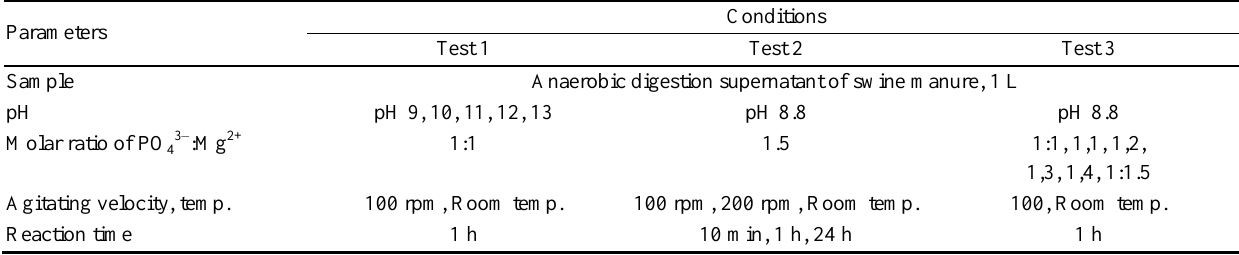
Table 2. Experimental conditions of struvite crystallization